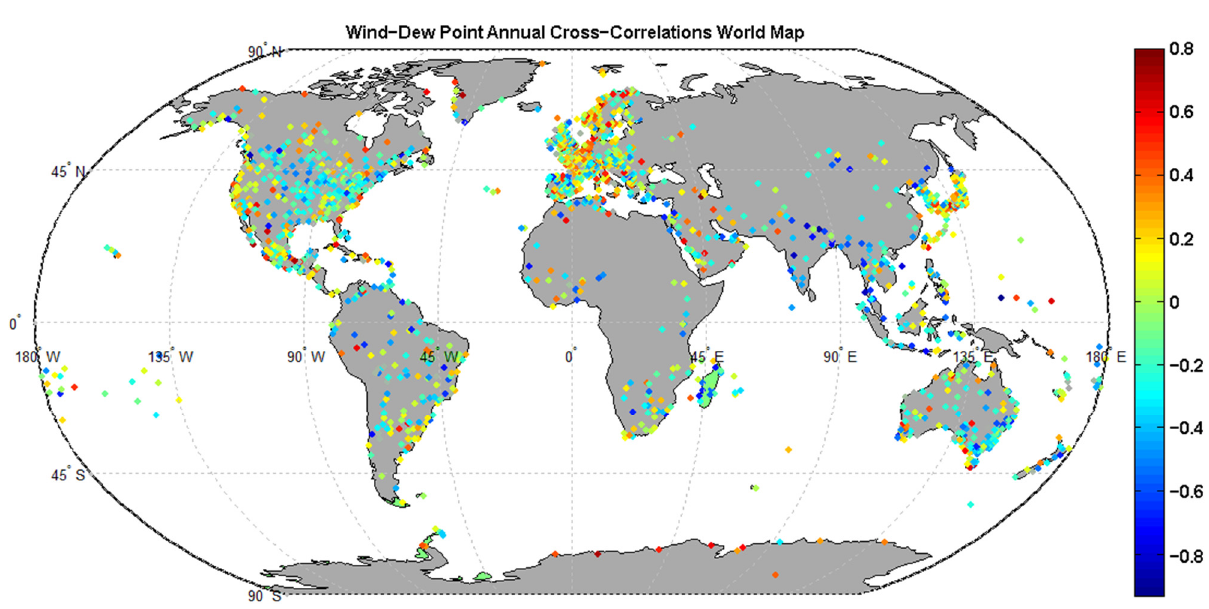
Figure 11. Cross–correlations between global ‐ scale wind ‐ speed and dew ‐ point records of annual resolution. Results are color coded from red (strong positive) to blue (strong negative) cross–corre ‐ lations.